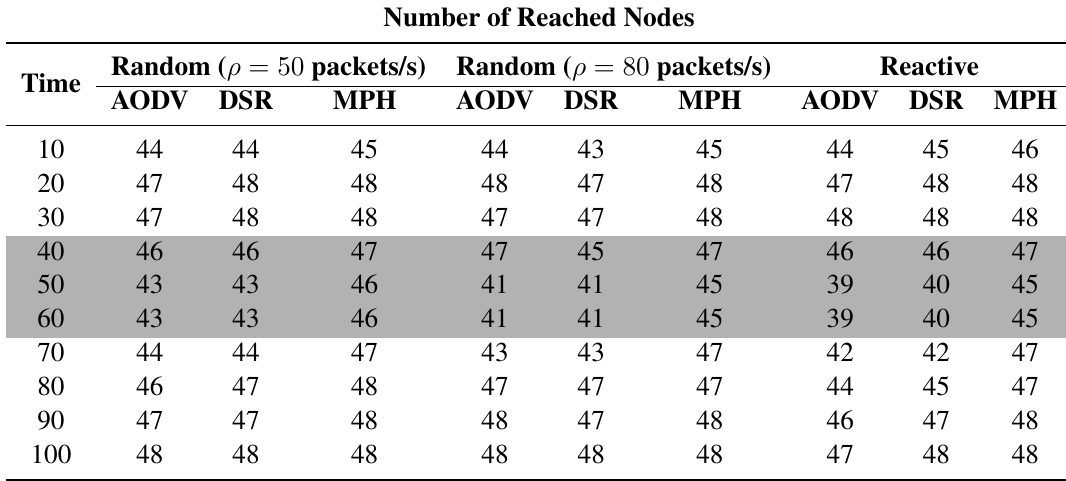
Table 7. Number of reached nodes by the coordinator when the jammer node is far. Number of Reached